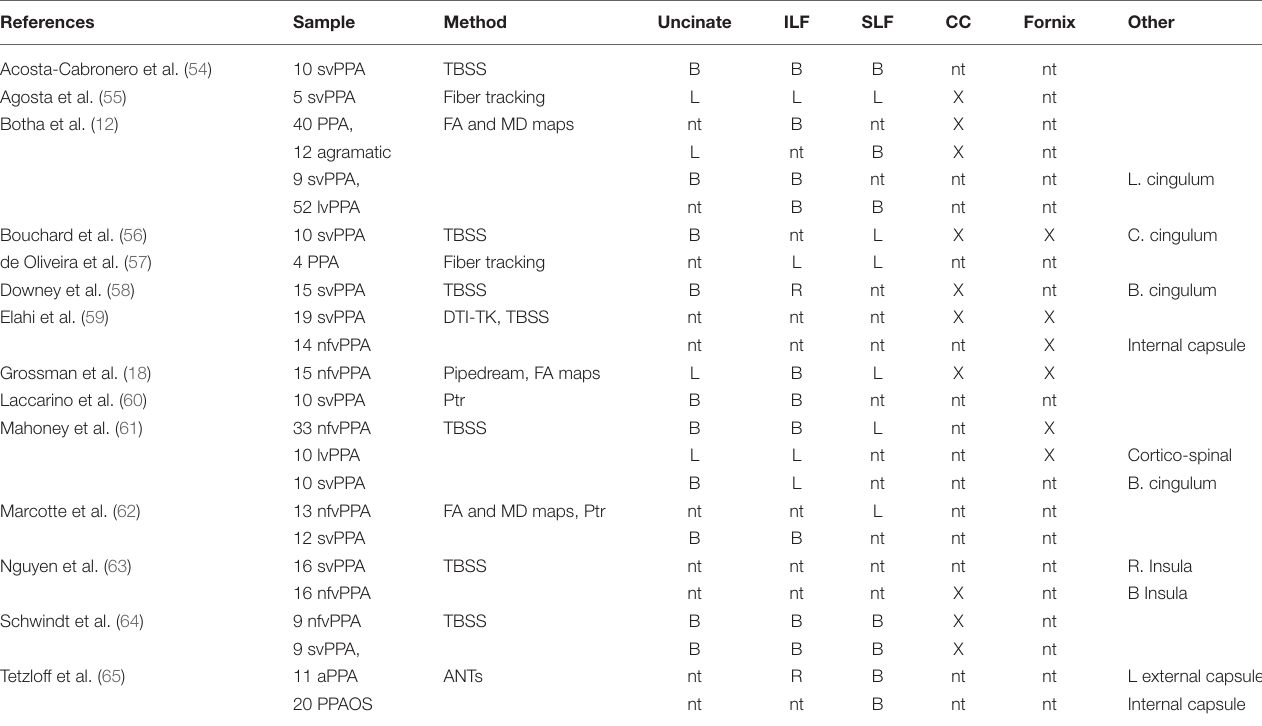
TABLE 2 | Comparison of fractional anisotropy and mean diffusivity changes in DTI studies of PPA.